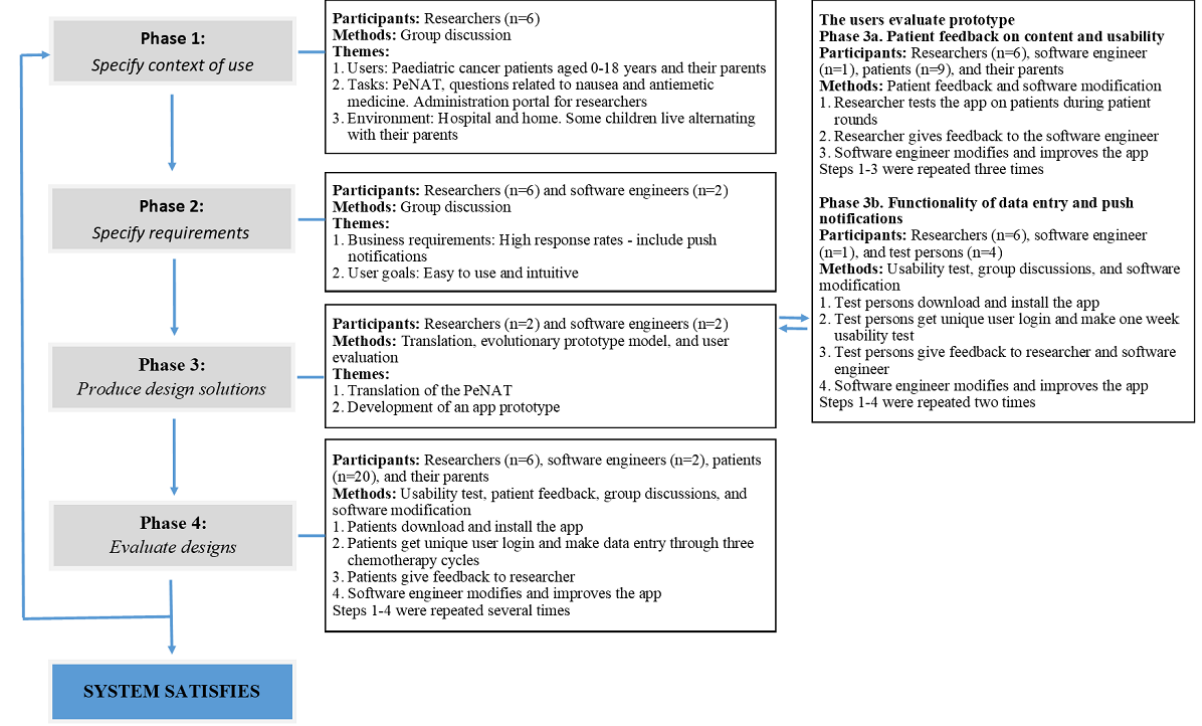
Figure 2. Workflow of the development and evaluation process according to the user-centered design process and the evolutionary prototype